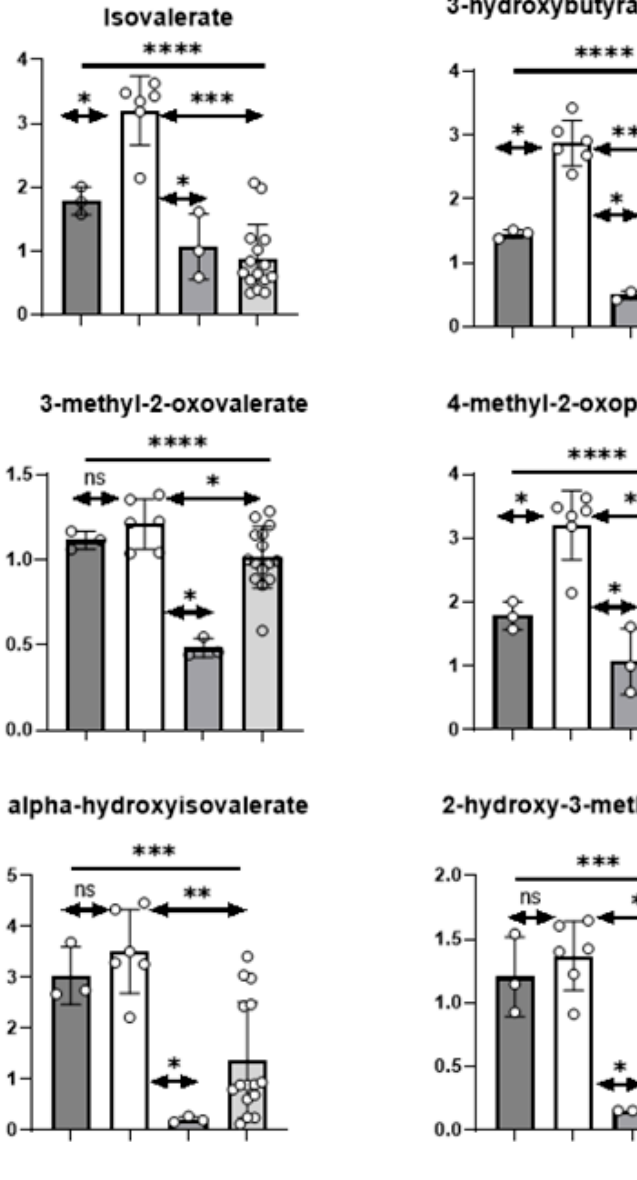
Figure 8. Volatile metabolites distinguishing LR MPPOL, HR IPPOL, and normal oral keratinocytes. The bar charts show selected volatile metabolites from the unbiased metabolic screen that distinguish LR MPPOL, HR IPPOL, and normal oral keratinocytes in vitro. The data are the results of three independent experiments +/ − standard deviation derived from one line of healthy normal keratinocytes, two lines of LR MPPOL keratinocytes, D17, and five lines of HR IPPOL keratinocytes. The data are not normalised for cell number or protein, but are from cultures of equal surface area. Dark grey bars = normal oral keratinocytes; white bars = LR PPOL keratinocytes; lighter grey bars = D17, and very light grey bars = HR IPPOL keratinocytes. Significant by one-way ANOVA (bar) or Welch’s Test (arrowed Lines) * p < 0.05; ** p < 0.01; *** p < 0.001; and **** p < 0.0001.